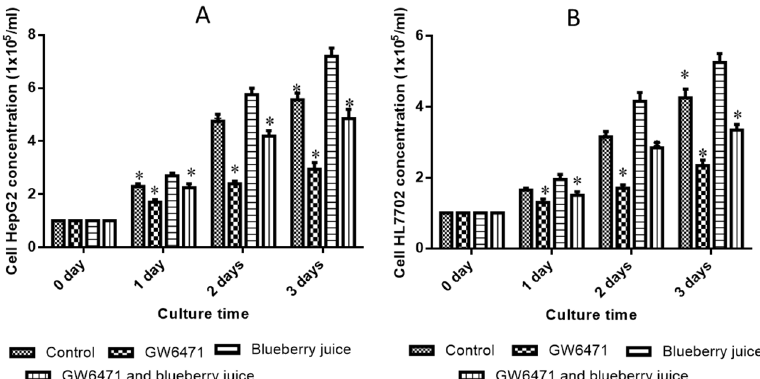
Figure 2. The effects of PPAR ‐α antagonist and blueberry juice on the growth of human liver cells: ( A ) the effects of PPAR ‐α antagonist and blueberry juice on the growth rate of cell line HL7702; and ( B ) the effects of PPAR ‐α antagonist and blueberry juice on the growth rate of liver cell line HepG2. All data are presented as mean value ± S.D. Five samples were analyzed in each group. * p < 0.05 via a blueberry juice group.